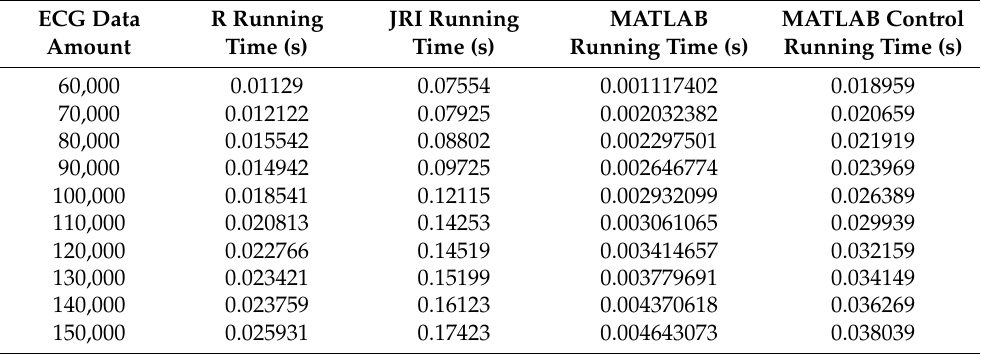
Table 3. Comparison of execution time using MATLAB, R programming, and Java